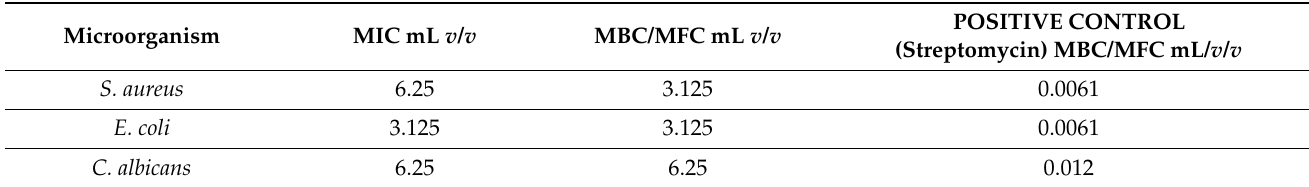
POSITIVE CONTROL (Streptomycin) MBC/MFC mL/ v / v